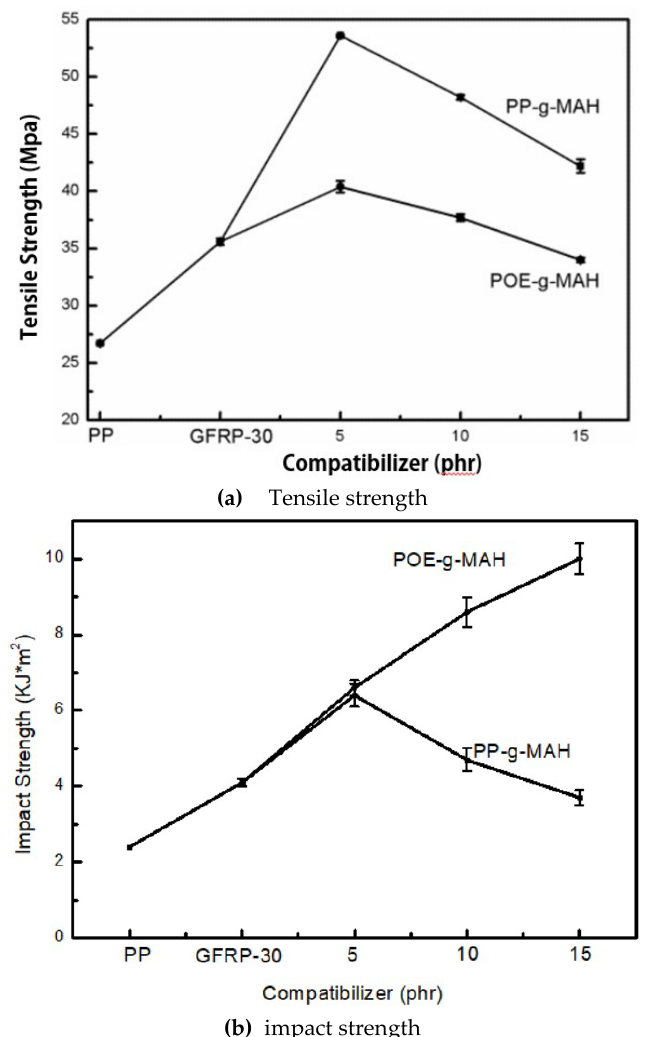
Figure 3. Effects of compatibilizers on the mechanical properties of GFRP (30 wt % GF): ( a ) Tensile strength; ( b ) impact strength. PP-g-MAH: Maleic anhydride-grafted polypropylene; POE-g-MAH: